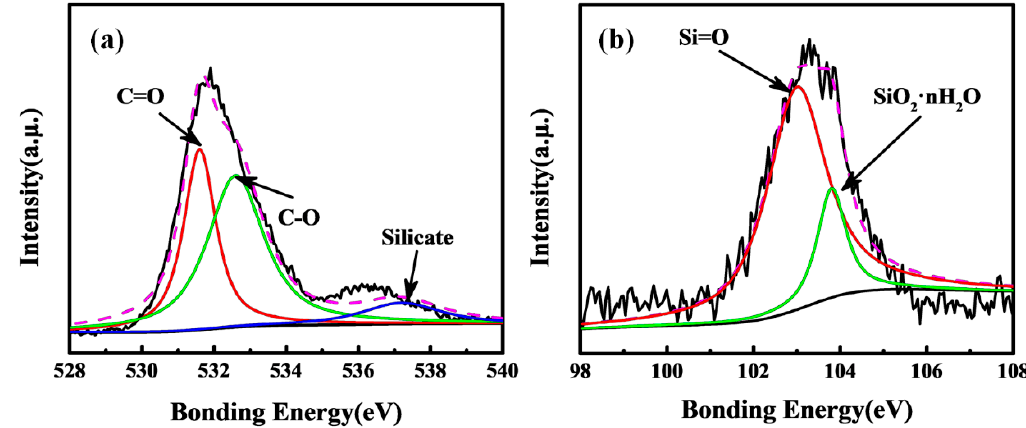
Figure 4. Curve fitting of O1s ( a ) and Si2p ( b ) photoelectron peaks.